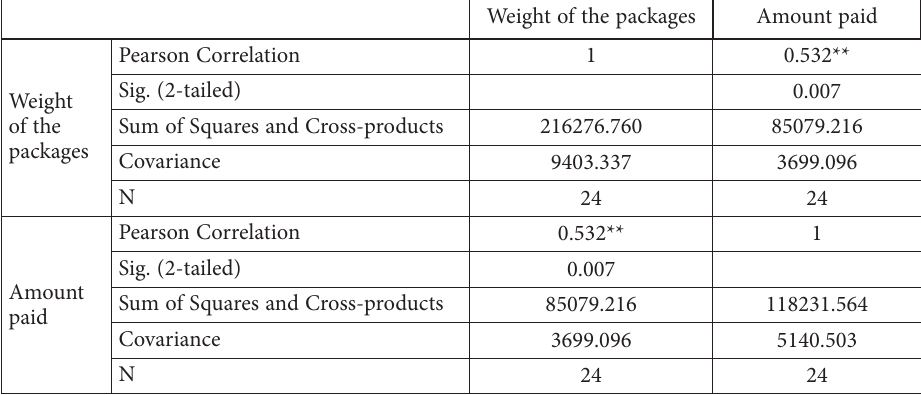
Weight of the packages Amount